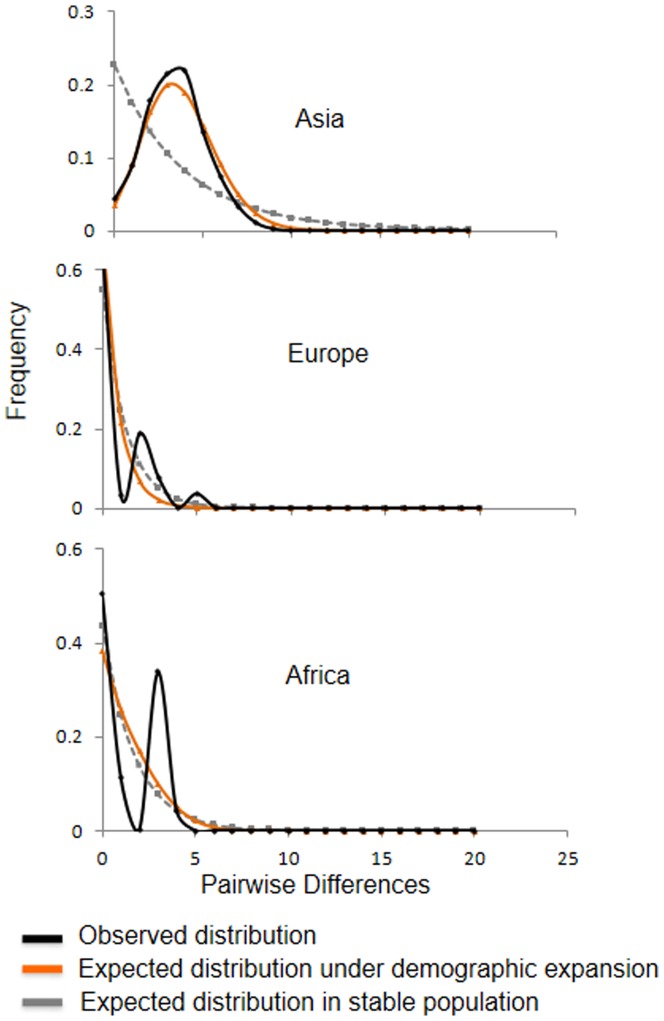
Mismatch distributions of cyt-b haplotypes.Expected distributions were modeled for stable populations and populations undergoing demographic expansion by using the parameters τ, θ0 and θ1 provided in Table 3.